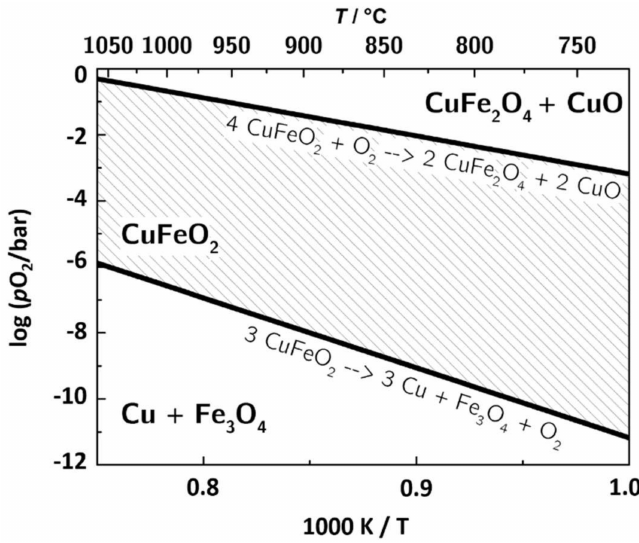
Figure 4. Ellingham diagram of the CuFeO 2 , CuFe 2 O 4 , CuO, and the Fe 3 O 4 system, respectively.